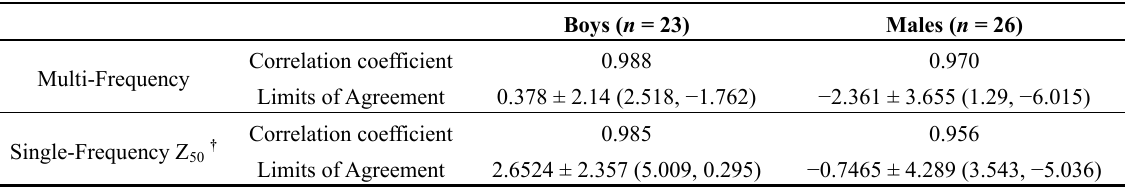
Table 4. Variability of TBW estimation using different frequencies compared with the dilution